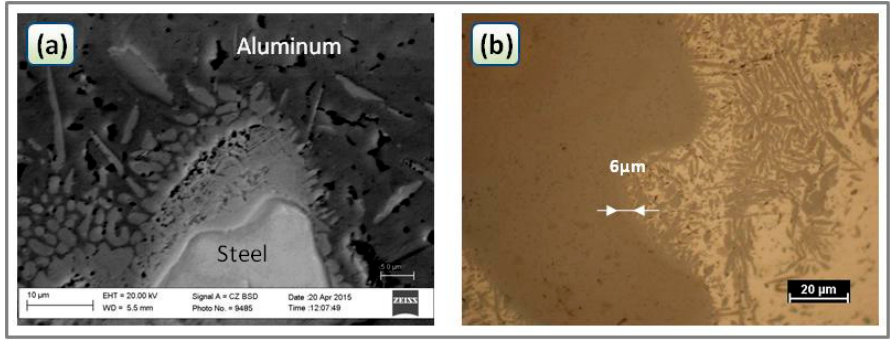
Figure 10. ( a ) Scanning electron microscopy (SEM) and ( b ) optical micrographs showing the IMC